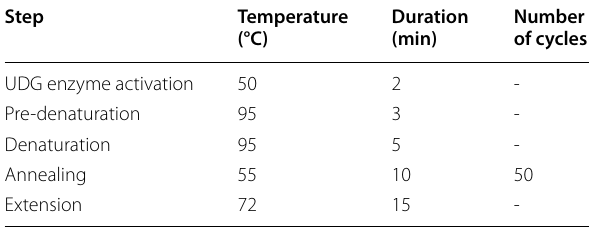
Table 3 qRT-PCR reaction